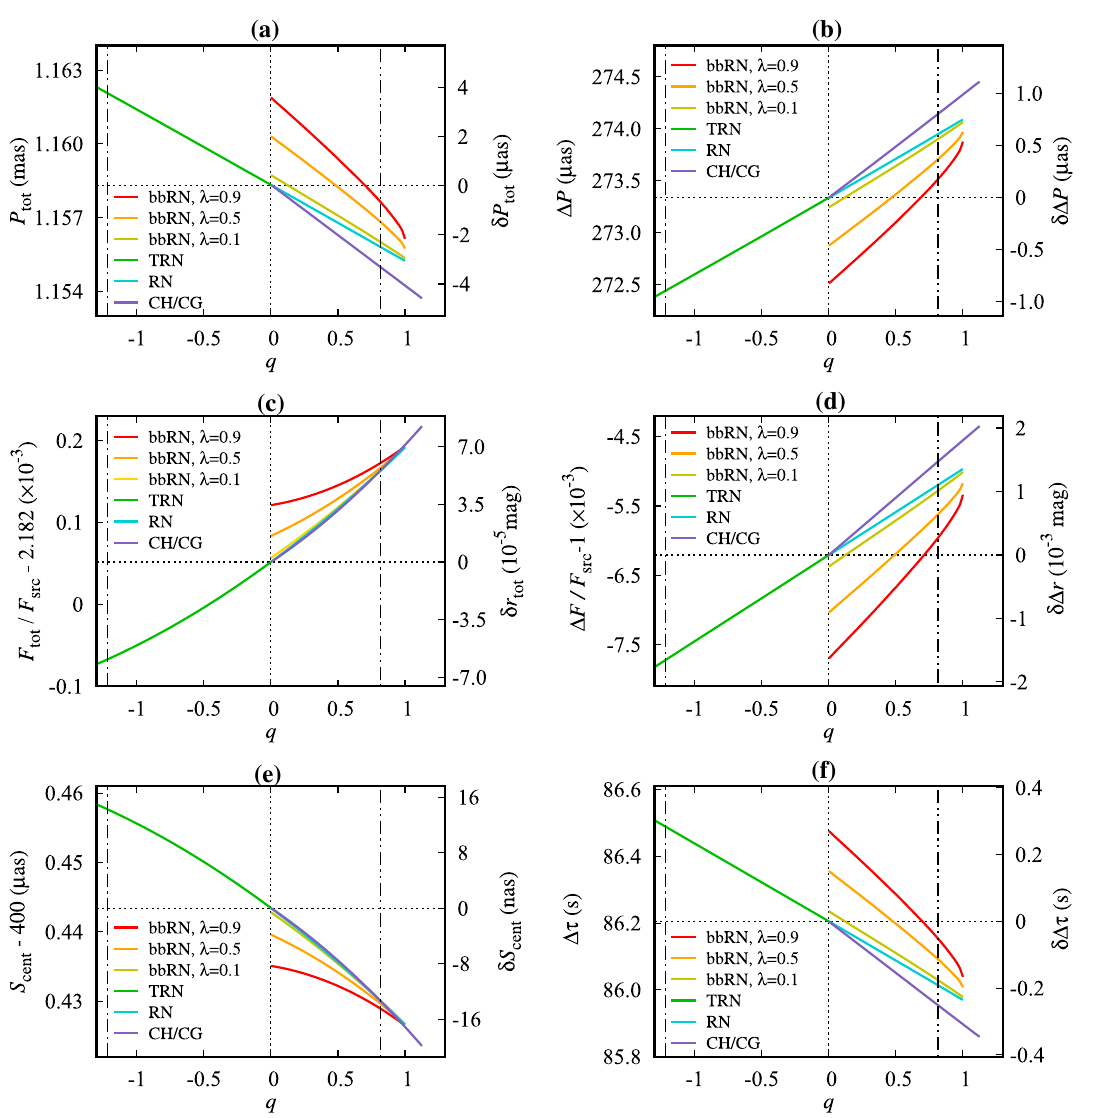
β = 0 . 5. The left and right dash-dotted lines mark the lower and upper bound on q based on the shadow of M87* observed by EHT, see Eqs. (10) and (11). The horizontal dotted lines denote those